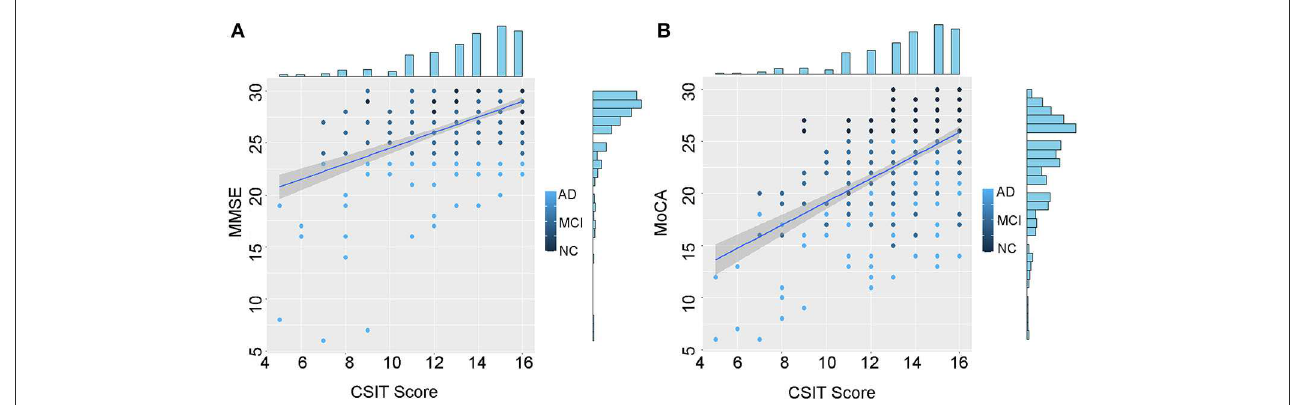
FIGURE2 Scatter plots of the CSIT score against MMSE or MoCA in all the included cases. (A) Correlation between the CSIT score and the MMSE score and (B) correlation between the CSIT score and the MoCA score.